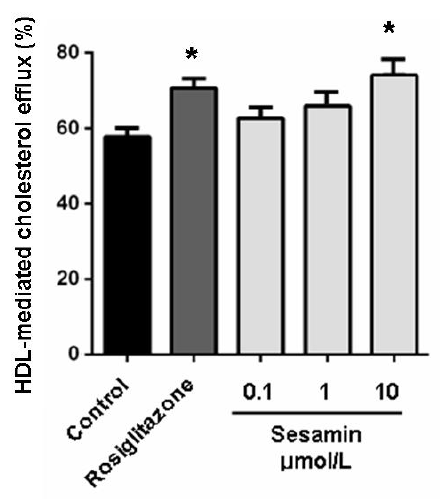
Figure 2. Sesamin enhances HDL-mediated cholesterol efflux from RAW264.7 macrophages. Cells were treated with rosiglitazone (1 μ M) or indicated concentration of sesamin for 6 h after incubation with 25-NBD cholesterol for 24 h. Values represent mean ± SD. Results are representative of four different experiments. * p < 0.05 versus control